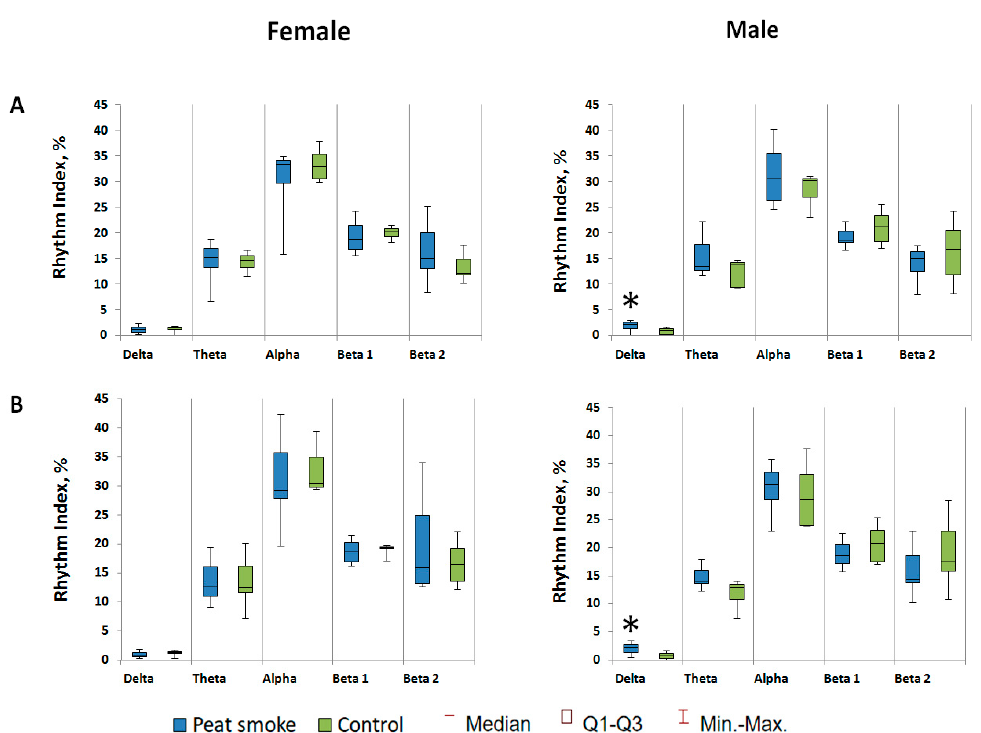
Figure 6. EEG parameters of F1 offspring: rhythm indices of the left ( A ) and right ( B ) hemispheres. * p < 0.05.